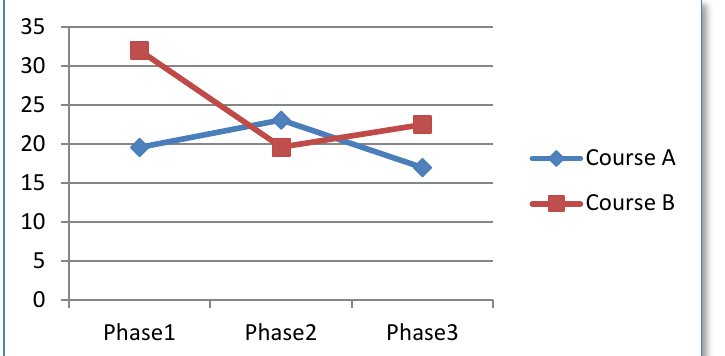
Figure 3. Average number of behavioral interactions with the Moodle LMS for each phase of the semester for two